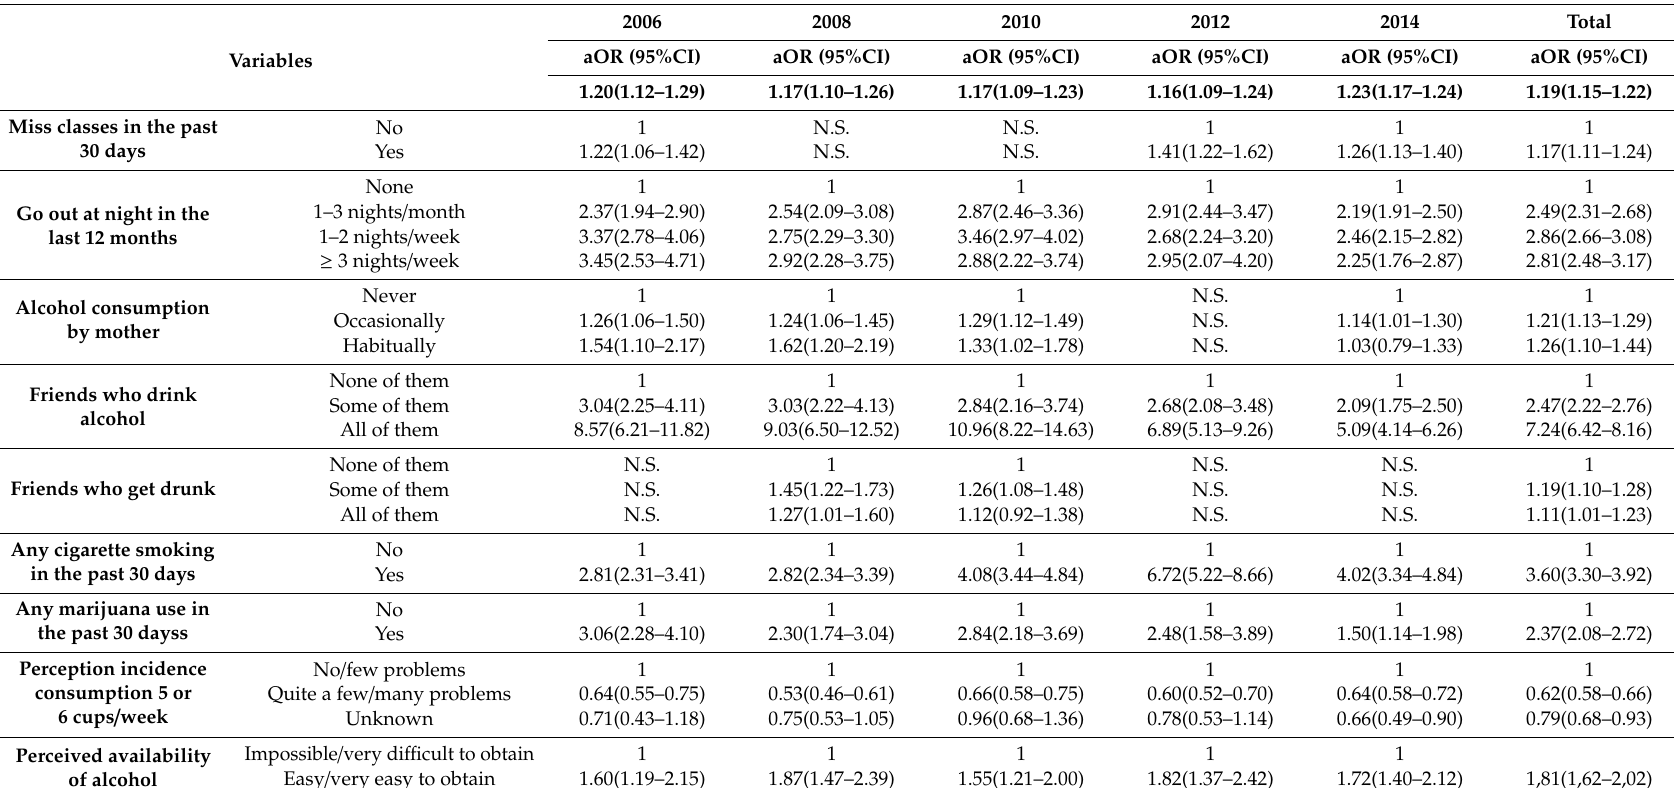
Table 4. Factors associated with alcohol consumption in Spanish female adolescents aged 14 to 18 years. ESTUDES surveys